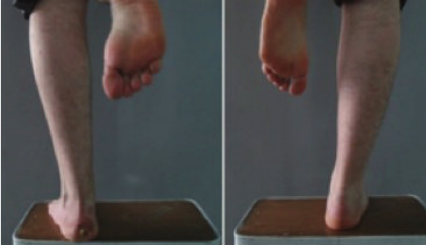
Figure 4: Clinical images showing differences in opposite extremi- ties due to